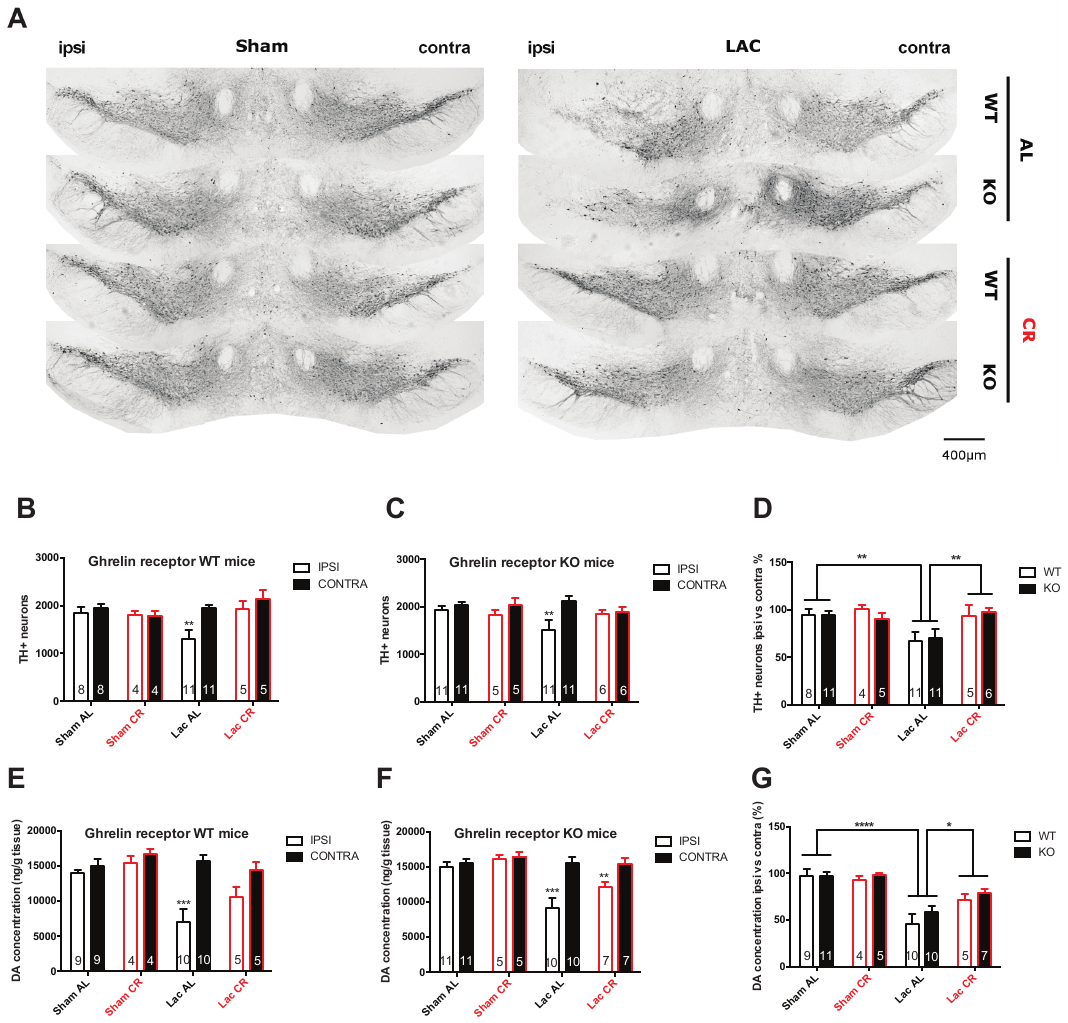
Figure 3. Degeneration of the nigrostriatal pathway in sham- and LAC-injected ghrelin receptor WT and KO mice fed AL or under CR. ( A ) Representative photomicrographs of tyrosine hydroxylase (TH) staining in the SNc of ghrelin receptor WT and KO mice under AL or CR feeding conditions seven days post-lesion (scale bar = 400 µ m); ( B – D ) The number of TH+ neurons and percentage of TH+ cell loss of the ipsilateral SNc compared to the contralateral SNc seven days after LAC administration in CR and AL-fed WT and KO mice; ** p < 0.01 versus contra ( B , C ); Two-way ANOVA followed by a post-hoc Sidak’s multiple comparison test) or ** p < 0.01 versus sham AL or LAC CR ( D ); Two-way ANOVA followed by a post-hoc Sidak’s multiple comparisons test) ( E – G ); DA concentration (ng/g tissue) and percentage of DA loss in the ipsilateral striatum compared to the contralateral striatum seven days after LAC administration in CR and AL-fed ghrelin receptor WT and KO mice. *** p < 0.001 versus contra ( E – F ); Two-way ANOVA followed by a post-hoc Sidak’s multiple comparison test or * p < 0.01, *** p < 0.001 versus sham AL or LAC CR ( G ); Two-way ANOVA followed by a post-hoc Sidak’s multiple comparison